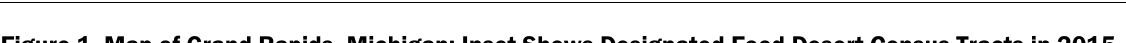
Figure 1. Map of Grand Rapids, Michigan; Inset Shows Designated Food Desert Census Tracts in